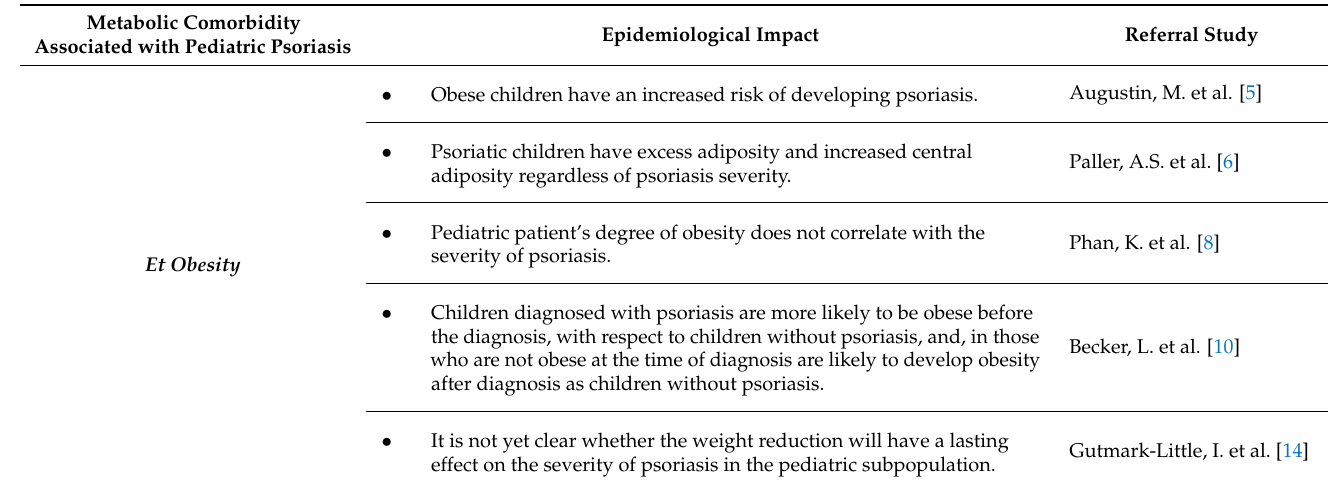
Table 1. A summary of the metabolic comorbidities associated with pediatric psoriasis. Metabolic Comorbidity Epidemiological Associated with Pediatric Psoriasis